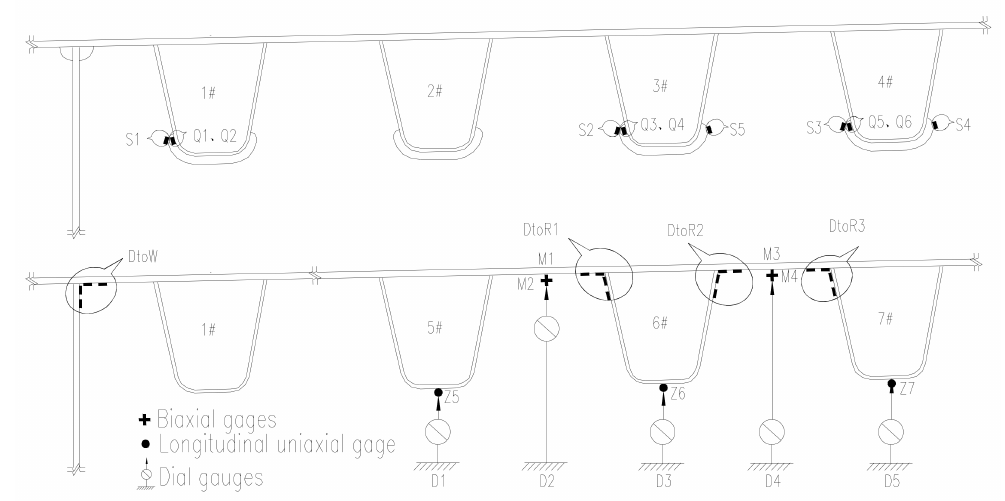
Figure 6. A and B sections layout of instrumentation.